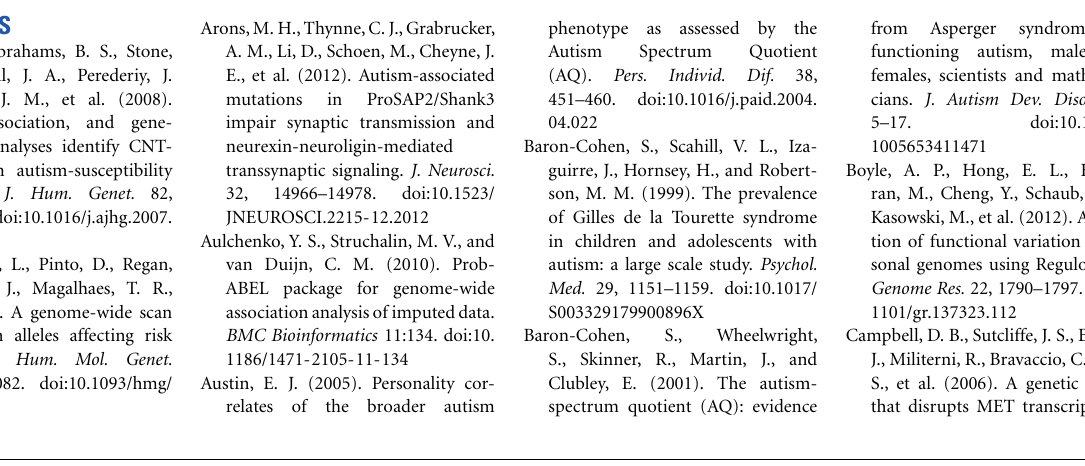
Figure S4 | Histogram and Quantile–Quantile Plot of Communication/Mindreading Scores . Histogram depicts the frequency of the Communication/Mindreading observations. Q–Q plots compare the quantiles from the current study (sample quantiles) to the quantiles from a Normal distribution (theoretical